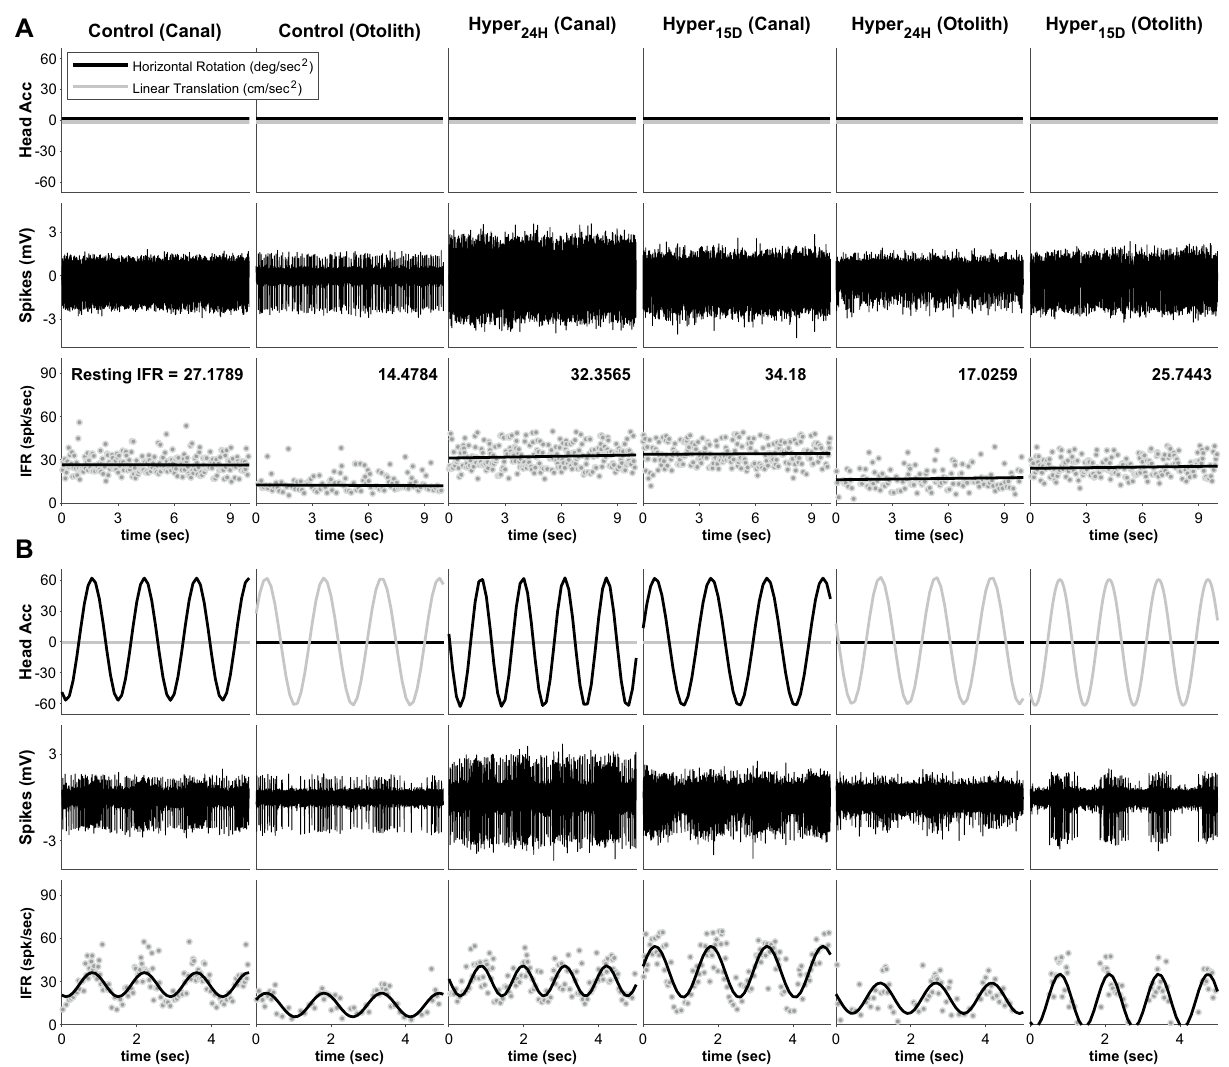
Figure 2. Exampled neuronal responses depending on the exposing periods to hypergravity. The averaged firing rates (FR) were obtained from the resting FR during 10-secconds long ( A ), and their responses to the given kinetic stimulations were presented ( B ). The units of head acceleration were deg/s 2 and cm/s 2 for horizontal head rotation (black line) and linear transmission (gray line),